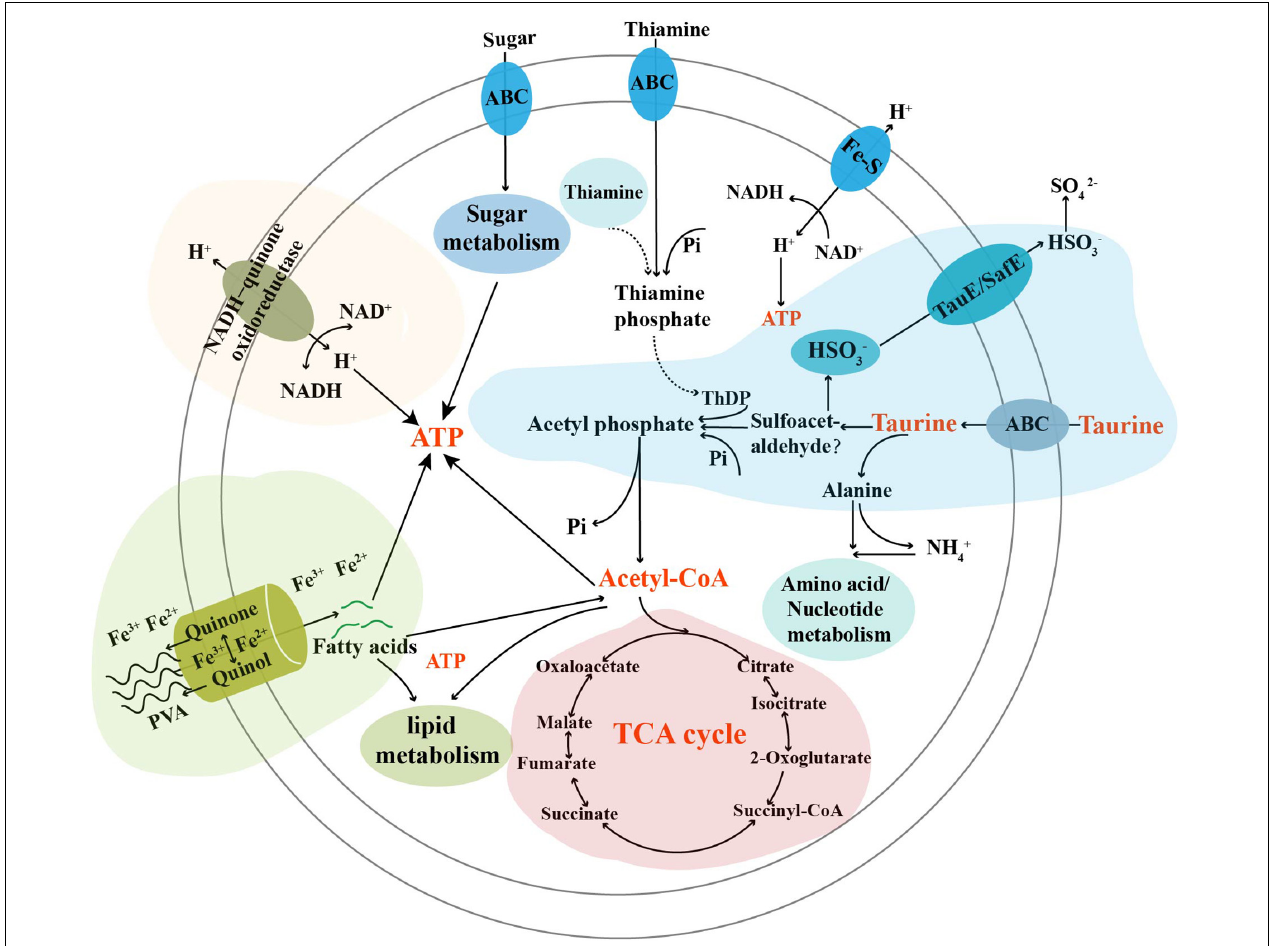
FIGURE 6 | Diagram of a proposed model describing degradation and utilization of taurine and PVA by Marmoricola sp. TYQ2. In this model, the metabolization of taurine and PVA as well as the contribution to energy production was highlighted. ThDP, thiamine diphosphate; Pi, phosphate